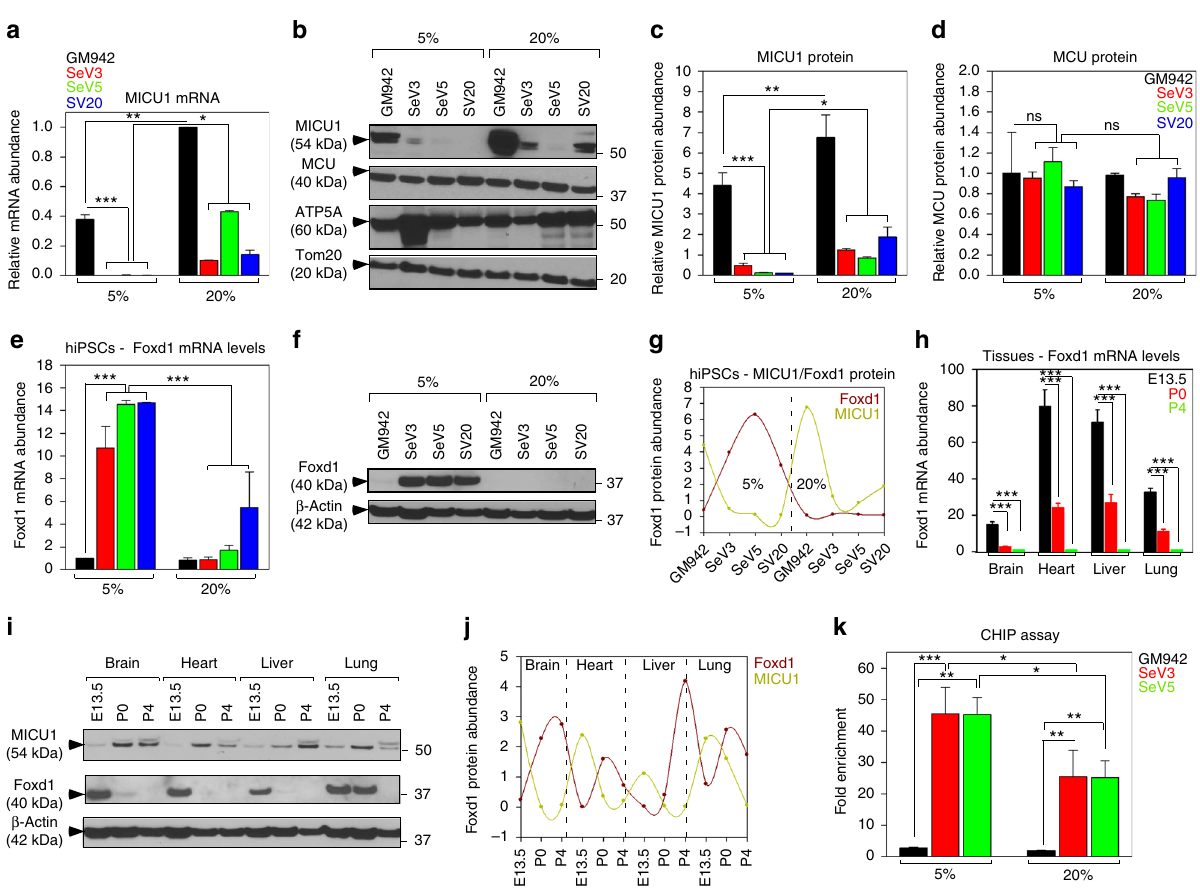
Fig. 2 MICU1 is transcriptionally regulated by Foxd1 under hypoxia. a Quanti fi cation of MICU1 mRNA abundance in hiPSCs exposed to normoxia (20% O 2 ) and hypoxia (5% O 2 ). b Representative western blot for lysates from control fi broblasts and hiPSCs grown under hypoxic/normoxic conditions and probed with antibody speci fi c for MICU1, MCU, ATP5A, and Tom20. c , d Quanti fi cation of relative MICU1 ( c ) and MCU ( d ) protein abundance in hiPSCs grown under hypoxic/normoxic conditions. e Quanti fi cation of Foxd1 mRNA abundance in hiPSCs under normoxia/hypoxia. f Representative western blot for lysates from control fi broblasts and hiPSCs grown under normoxic/ hypoxic conditions and probed with antibody speci fi c for Foxd1 and β -actin. g Quanti fi cation of relative protein abundance of Foxd1 and MICU1 quanti fi ed from f and b . h Quanti fi cation of Foxd1 mRNA abundance in various tissues (brain, heart, liver, and lung) harvested from different stages of embryonic development. i Representative western blot for lysates from brain, heart, liver, and lung harvested from embryos/neonates and probed with antibodies speci fi c for MICU1, Foxd1, and β -actin. j Quanti fi cation of relative protein abundance of Foxd1 and MICU1 quanti fi ed from i . k ChIP-assay was performed in hiPSCs exposed to normoxia and hypoxia. Antibody speci fi c for Foxd1 was used to immunoprecipitate the chromatin and the fold enrichment of micu1 promoter relative to the matched input control was quanti fi ed by qRT-PCR. Bar represents Mean± SEM, ** P < 0.01, * P < 0.05, *** P < 0.001; n = 3 – 5 (One-Way